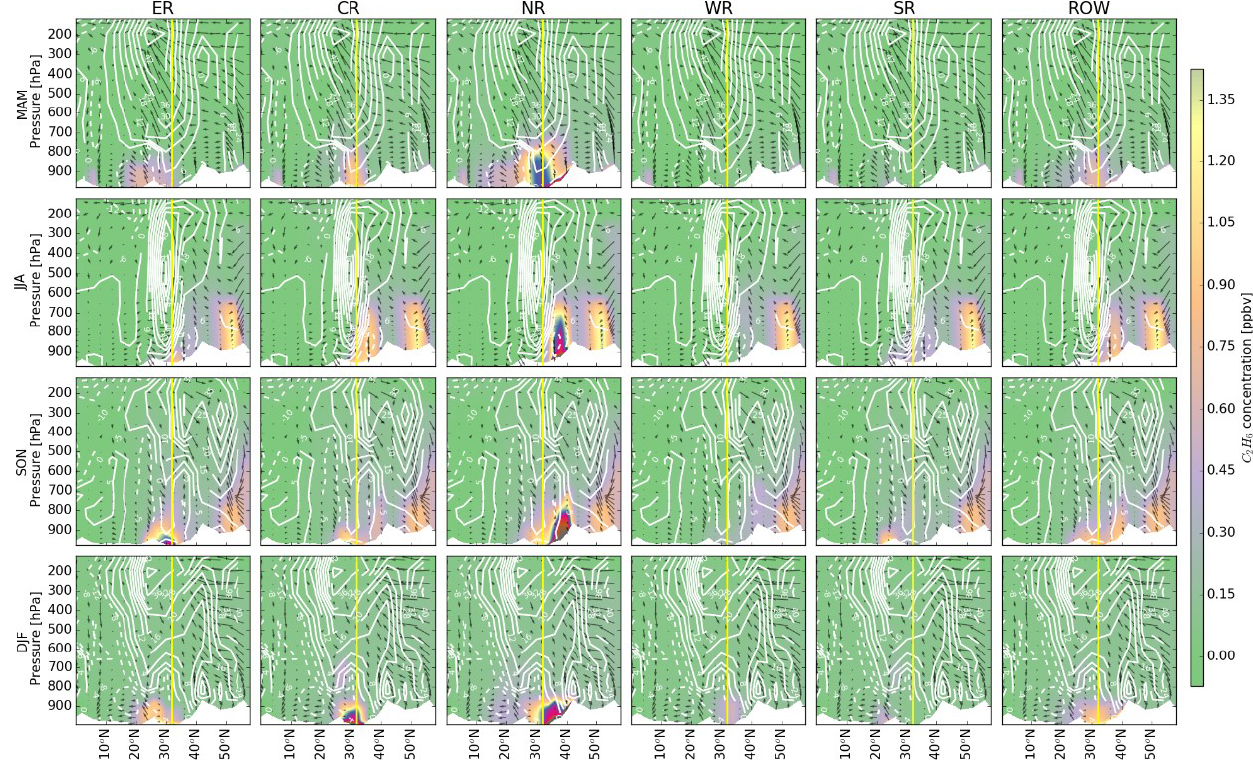
Figure 9. The first row shows the latitude–height distributions of the C 2 H 6 VMR averaged over 113–121 ◦ E in spring (MAM), originating from different source regions (corresponding to different columns). See Table 3 for latitude and longitude definitions. The white area indi- cates topography, and the white contours at intervals of 6ms − 1 are the easterly (dashed) and westerly (solid) mean meridional winds; the wind vectors (consisting of zonal wind in ms − 1 and vertical velocity in units of Pas − 1 ) are represented by arrows; the observation site is marked with a yellow line. The second to fourth rows are the same as the first row but for summer (JJA), autumn (SON), and winter (DJF), respectively. Meteorological fields are from the GEOS-FP 0.25 ◦ × 0.3125 ◦